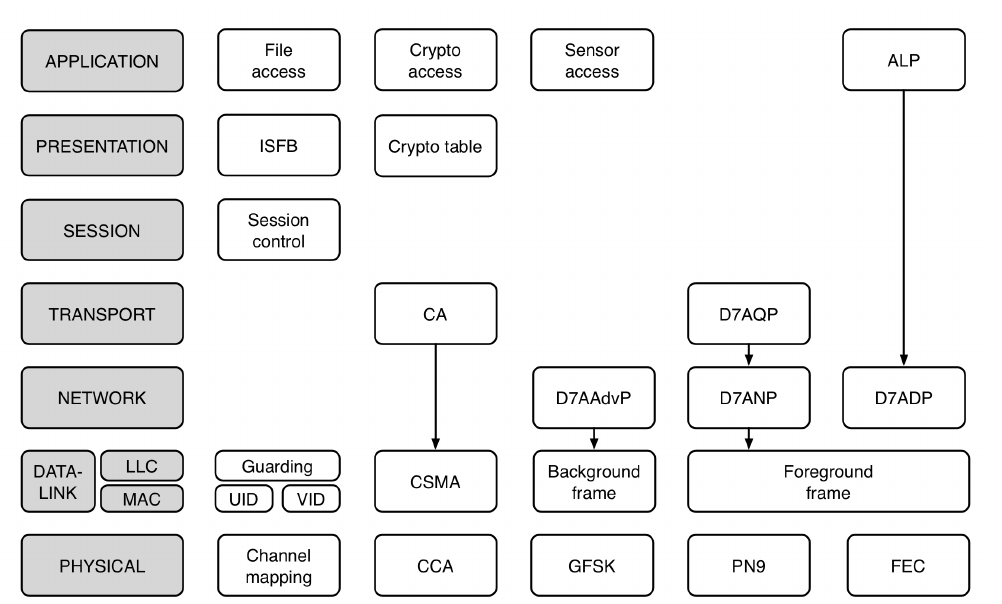
Figure 6. Stack organization of DASH7 Alliance